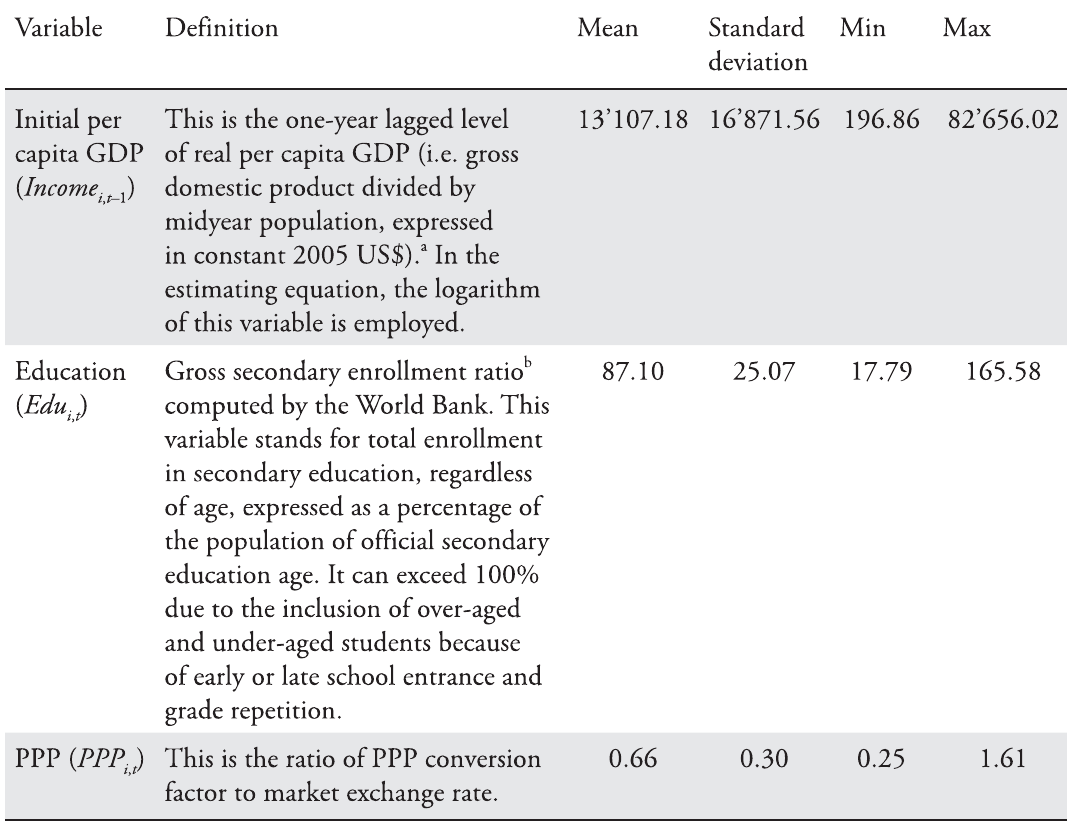
Table 4: Definition and Descriptive Statistics of the Explanatory Variables, 146 Countries, 2010-2014